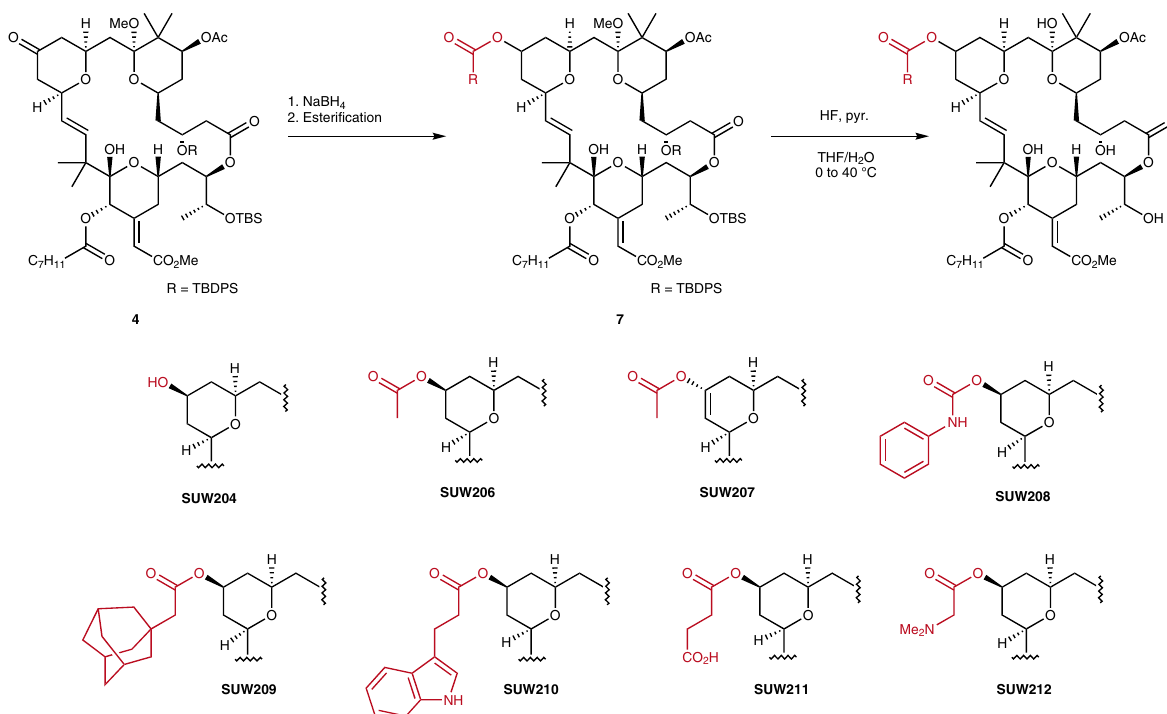
Fig. 4 Synthesis of C13 esters via reduction and esteri fi cation of C13 ketone. Esters were formed using standard esteri fi cation chemistries, including acylation with anhydrides, carbodiimide coupling, and carbamoylation with phenyl isocyanate ( SUW208 ). Detailed procedures for speci fi c transformations can be found in the Supplementary Methods.